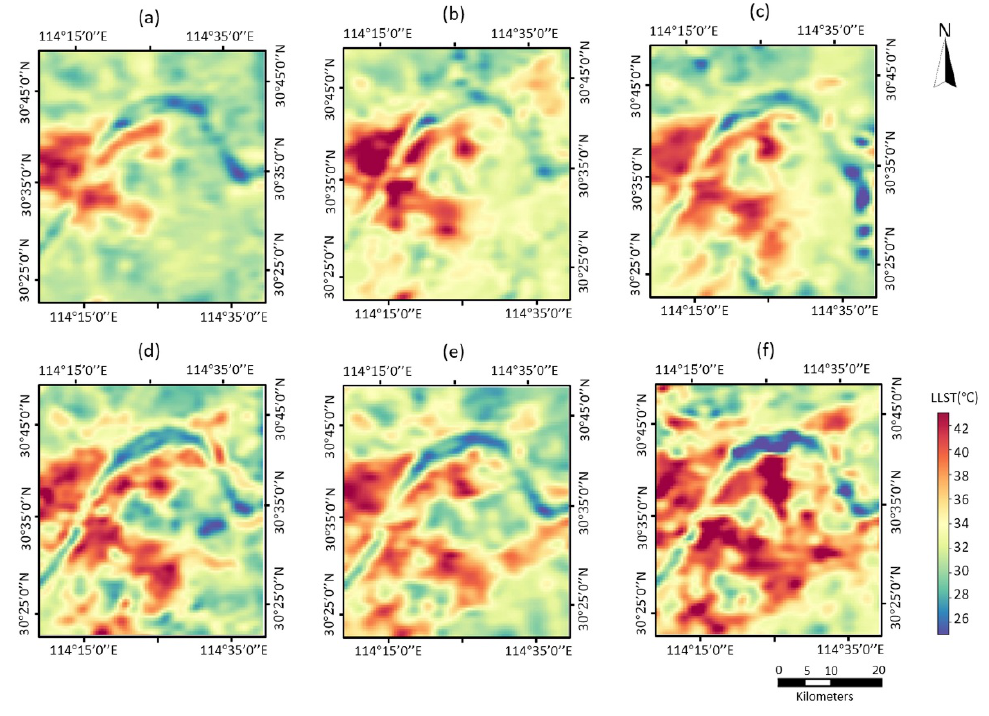
Figure 6. The LLSTs of the 6 years generated by MTGP. ( a ) 2002; ( b ) 2005; ( c ) 2008; ( d ) 2011; ( e ) 2014; ( f ) 2017. Table 3. The statistical summary of Latent Pattern of LST ( LLST) generation for each year.